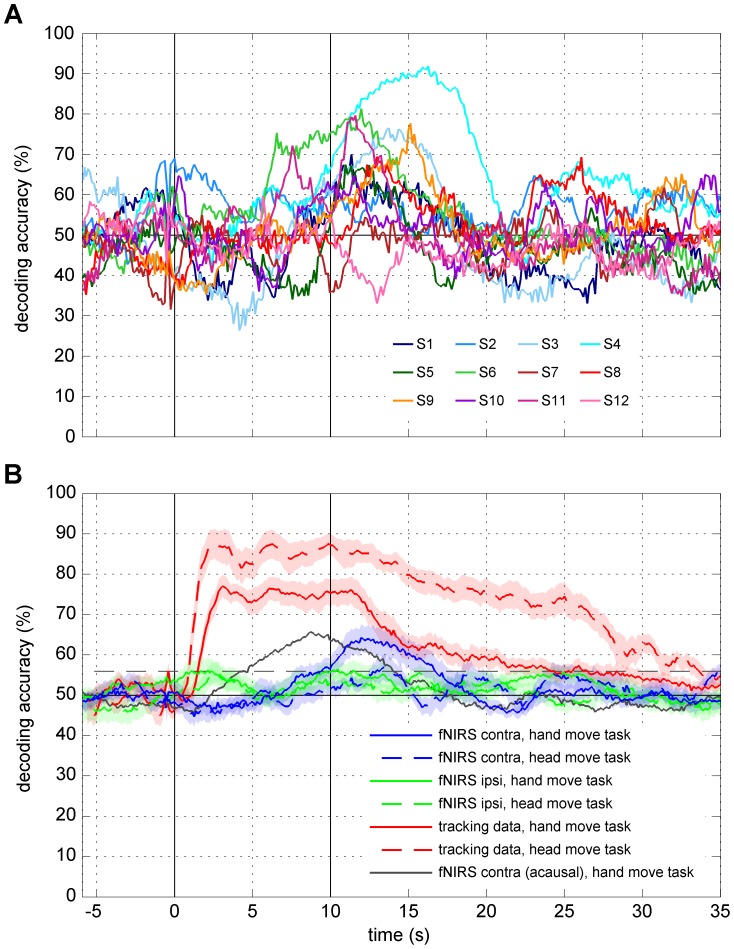
Time-resolved decoding accuracies.Time relative to movement onset, vertical black lines indicate movement onset and end, horizontal black line indicates chance level (50%). (A) Subject individual decoding accuracies (DAs) computed using fNIRS signals (HbO, causal filter) recorded above contralateral sensorimotor areas during hand movements (session 1). (B) Average DAs computed using precise head tracking data or using fNIRS signals (HbO, causal filter) recorded above different brain areas and during the different tasks (sessions 1 and 2, see Materials and Methods). Time-resolved DA based on acausally filtered fNIRS signals is shown for comparison (gray solid line, see Methods). Shaded areas reflect standard error of the mean and the dashed line the significance level (binomial test: p<0.001) for the average decoding accuracy across all subjects.